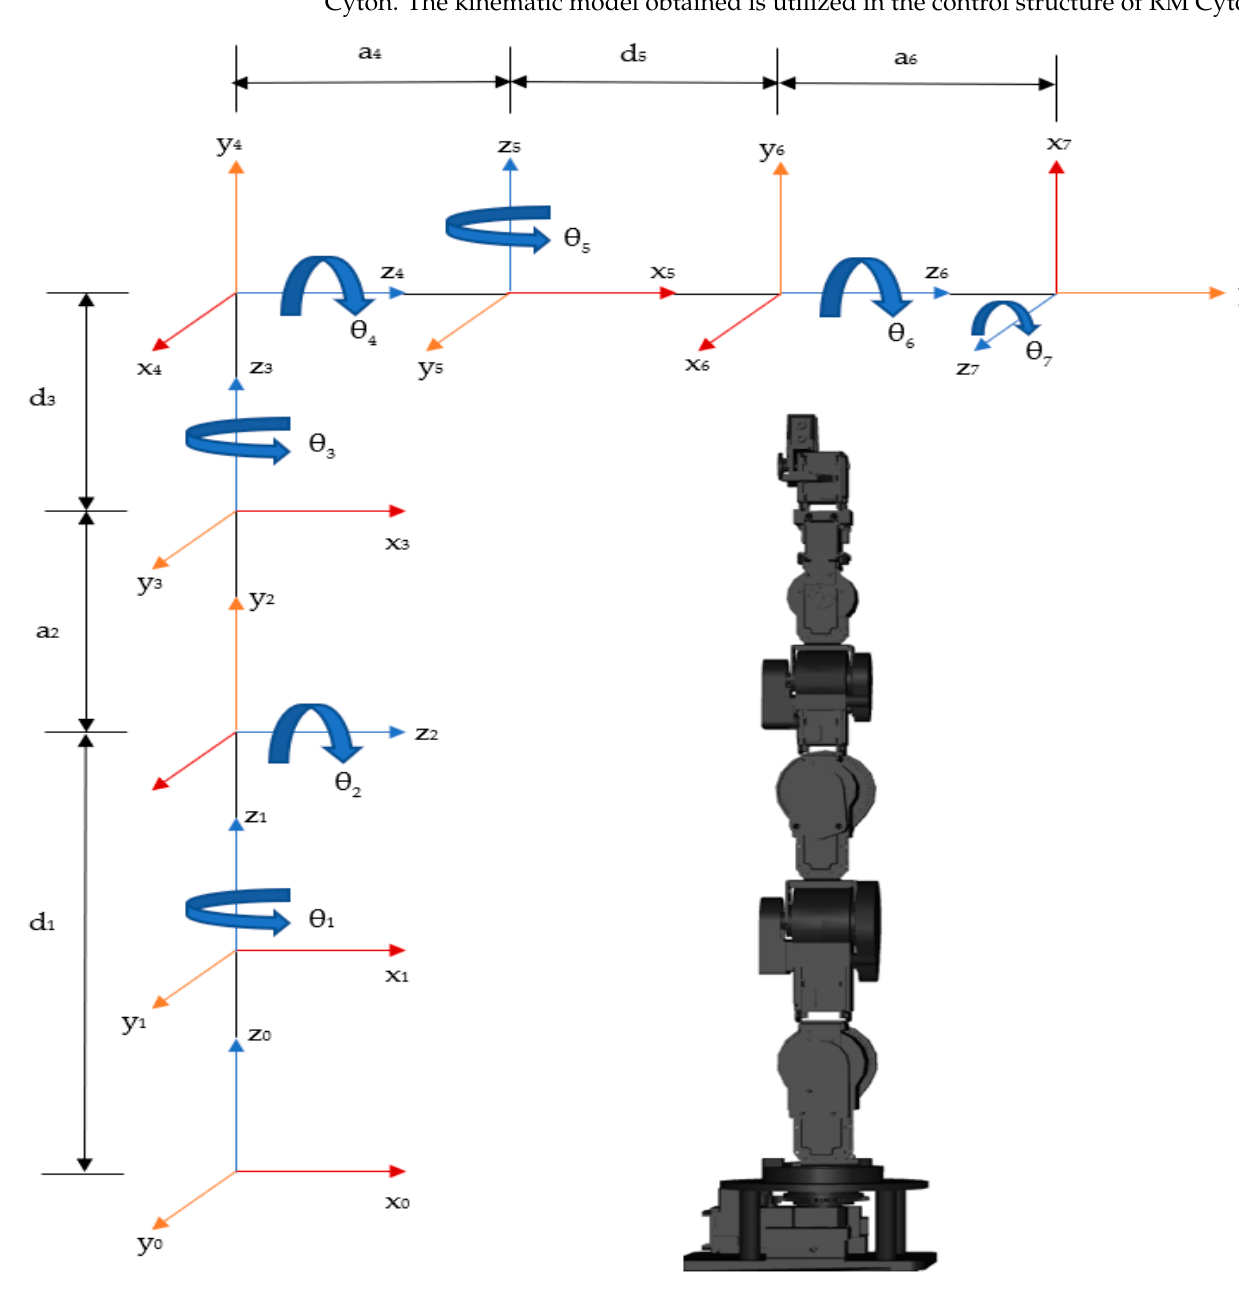
Figure 9. Joints and angles of 7-DOF RM Cyton 1500.